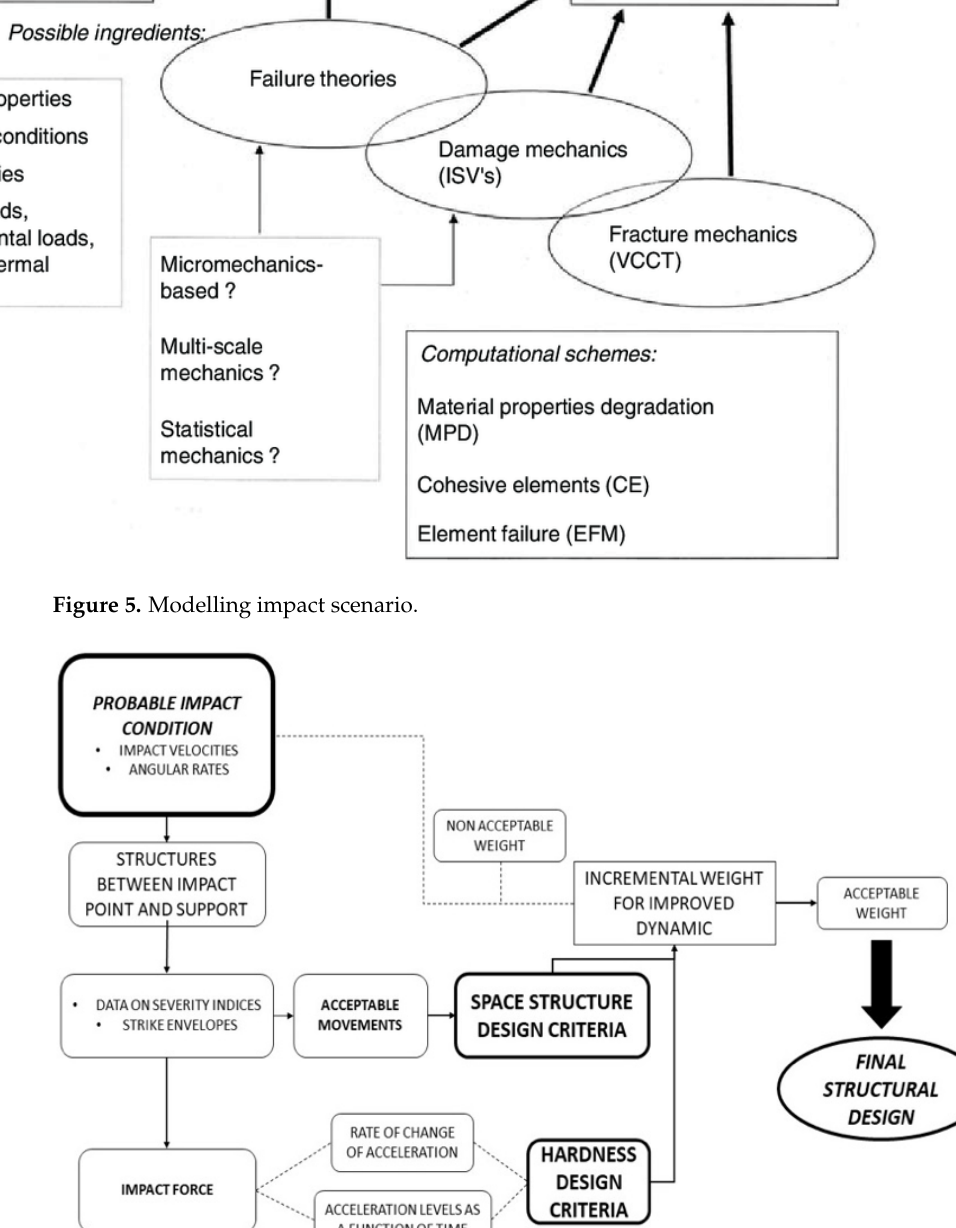
Figure 5. Modelling impact scenario.